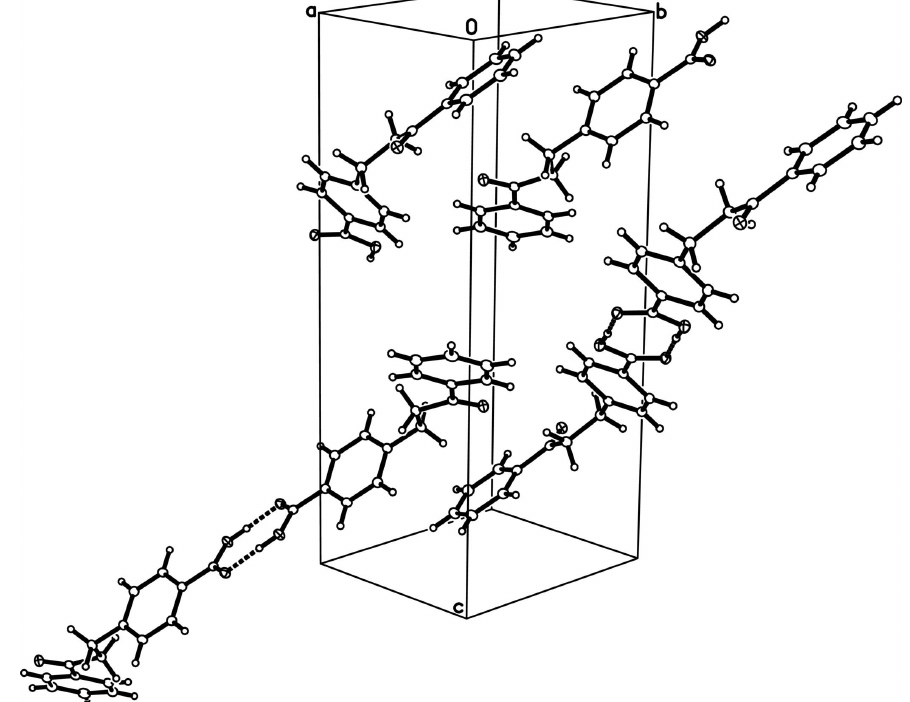
A partial packing diagram for (I), illustrating the dihedral relationships among the aromatic rings of the packed centrosymmetric dimers located at 1/2,1/2,1/2 and 1/2,0,0 in the unit cell. Displacement ellipsoids are drawn at the 30% probability